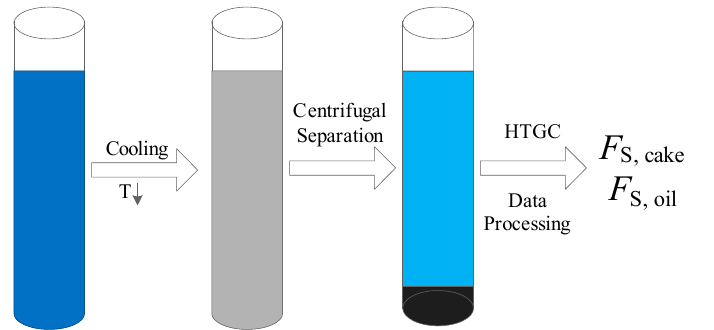
Figure 1. Sketch of the experimental procedure for determining the weight percent of precipitated wax in oil samples using the conventional C-HTGC